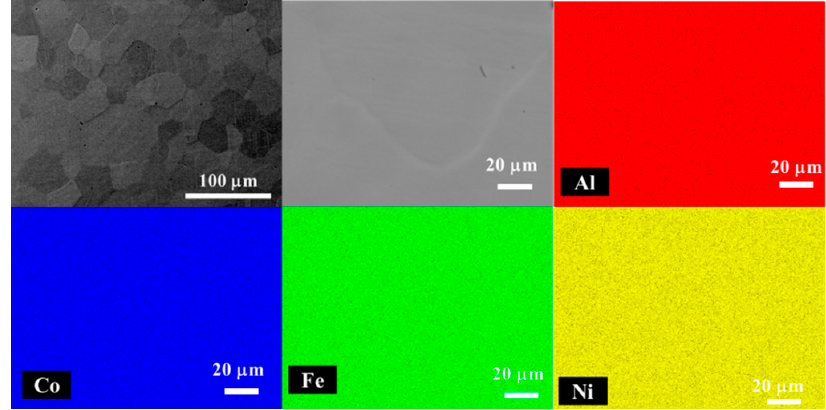
Figure 8. SEM-BSE image and elemental mapping of Al(CoFeNi) homogenized at 1373 K for 144 h.